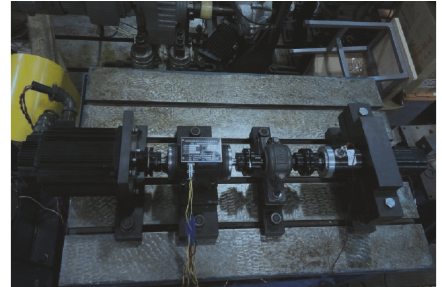
Figure 7: Platform of experiment.